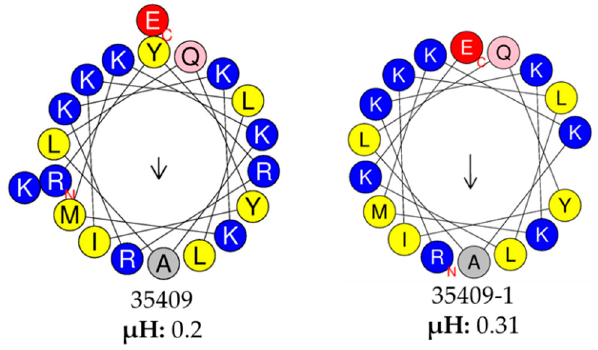
Figure 4. Helix representation and hydrophobic moment. The original peptide and peptide 35409-1 wheel projections are shown. The hydrophobic moment ( µ H) is shown in the lower part as a measure of amphipathicity. Yellow indicates non-polar amino acids and blue indicates polar amino acids. Arrow indicates helix non-polar face proportion and direction.